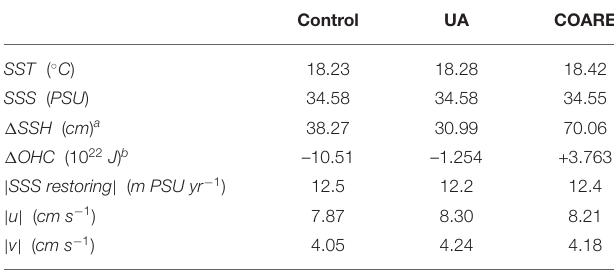
TABLE 5 | Ocean simulation global mean